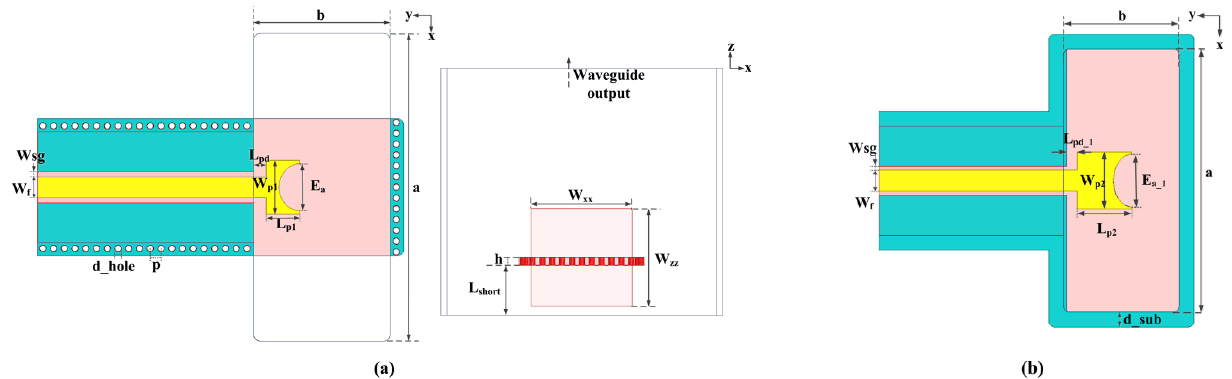
Figure 2. Layout of the proposed transitions: ( a ) the design with RT/Duroid 6010; ( b ) the design with RT/Duroid 5880.